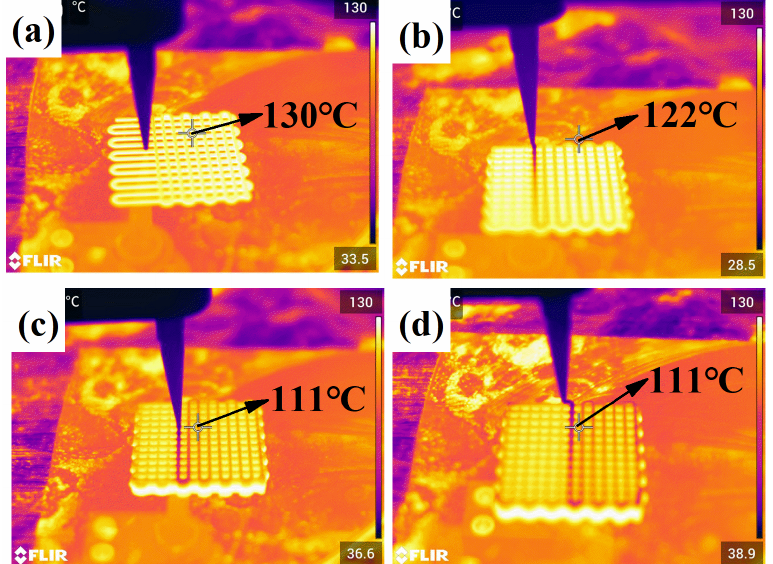
Figure 11. Thermal imaging camera picture during direct writing: ( a – d ) corresponds to the second layer, 4th layer, 8th layer, and 10th layer of the silicone foam, respectively. The figure shows that the temperature distribution of the first 10 layers is balanced. Additionally, the surface temperature of the highest layer (the 10th layer) is still above 110 °C. Polymers 2022 , 14 , 1323 12 of 15